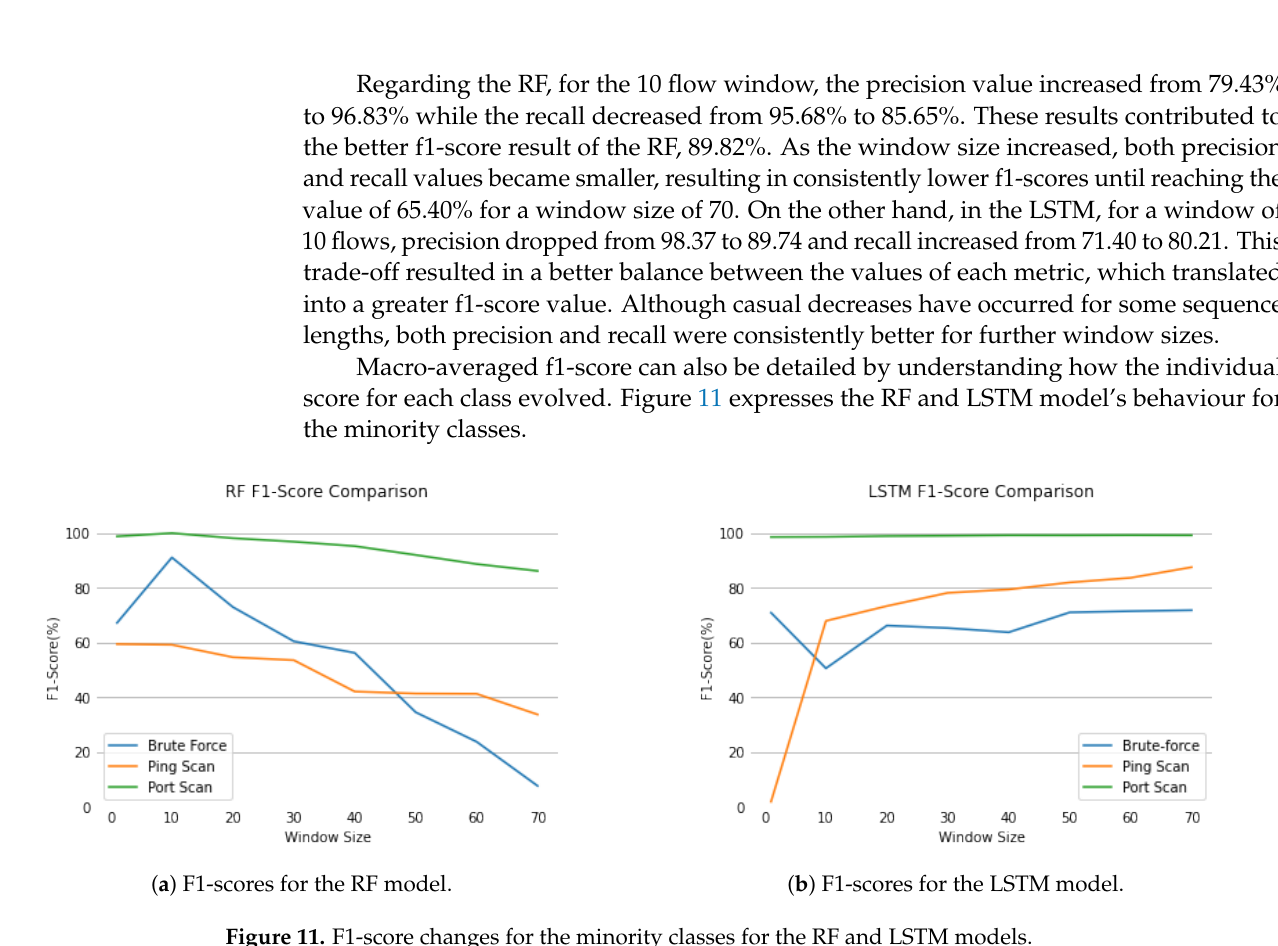
Figure 11. F1-score changes for the minority classes for the RF and LSTM